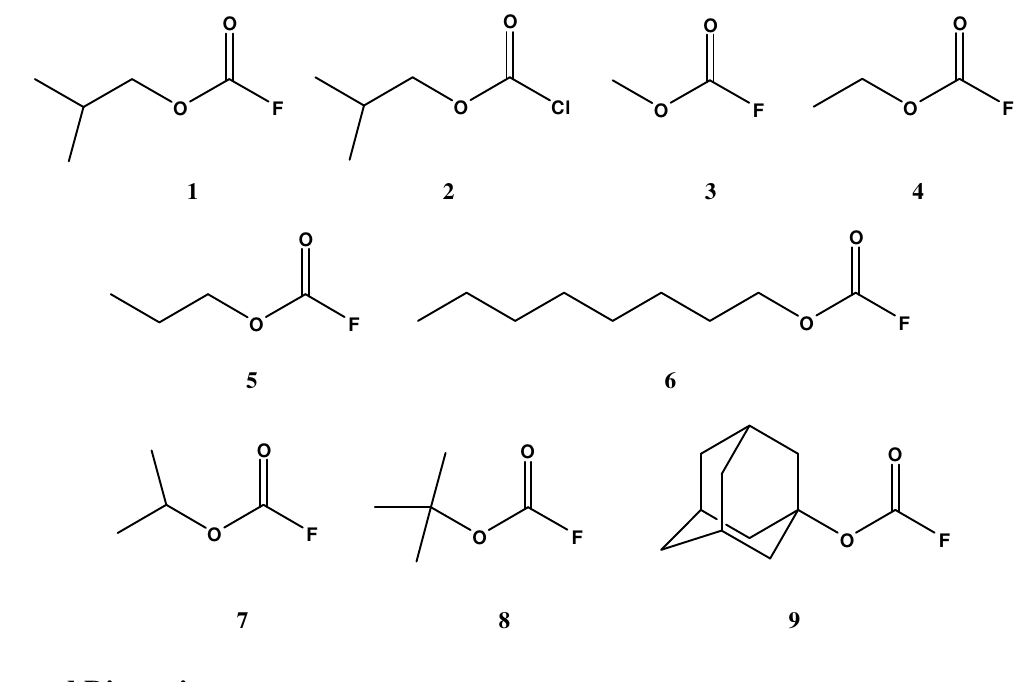
Figure 1. Molecular structures of isobutyl fluoroformate ( 1 ), isobutyl chloroformate ( 2 ), methyl fluoroformate ( 3 ), ethyl fluoroformate ( 4 ), n -propyl fluoroformate ( 5 ), n -octyl fluoroformate ( 6 ), isopropyl fluoroformate ( 7 ), tertiary butyl fluoroformate ( 8 ), and tertiary 1-adamantyl fluoroformate ( 9